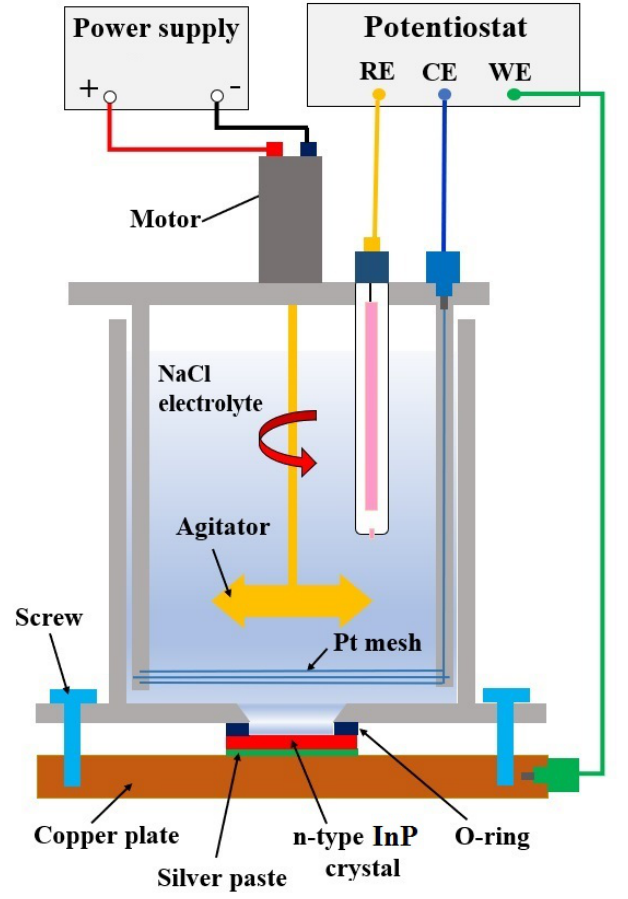
Figure 1. Schematic representation of the electrochemical etching